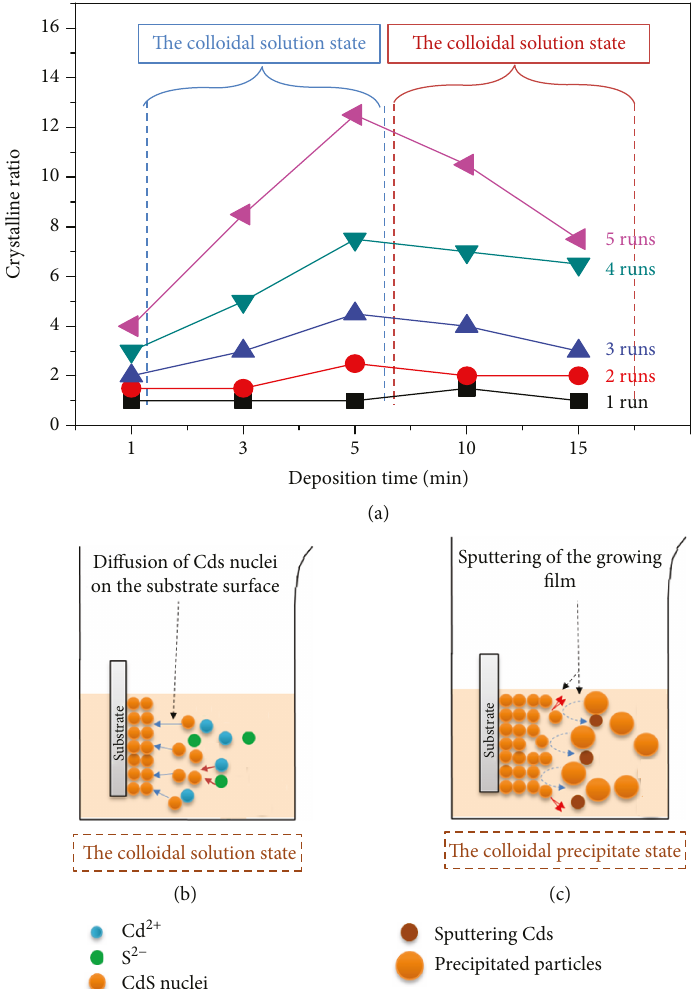
Figure 2: (a) Variation of the crystalline ratio as a function of number of runs and deposition time. Schematic representation of the growth states: (b) the colloidal solution state and (c) the colloidal precipitate